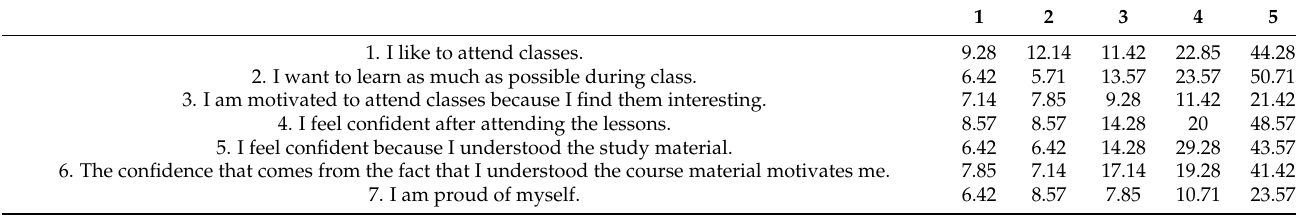
Table 3. Part III: Students’ class involvement